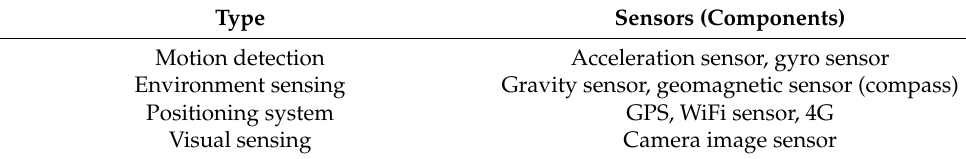
Table 1. Sensor classification by